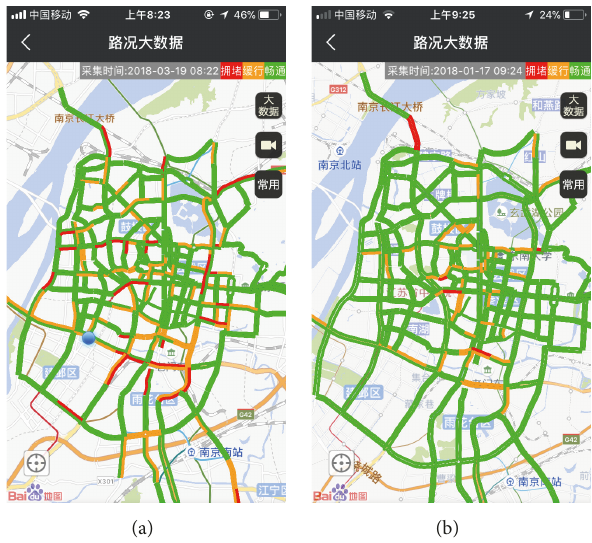
Figure 4: Morning peak traffic periods (source: Nanjing big